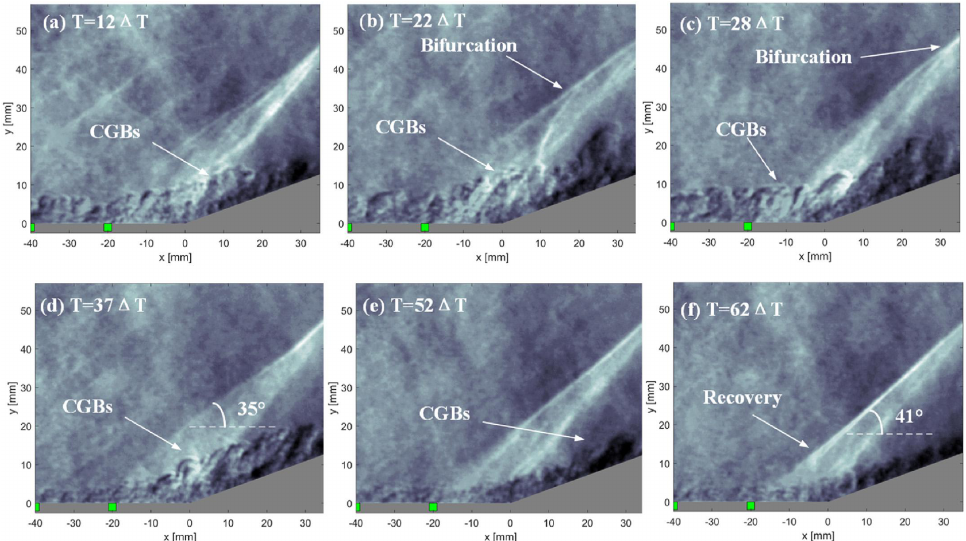
Figure 17. Interaction of the heated region with the separation shock. Reprint from [55] with permission from Elsevier.